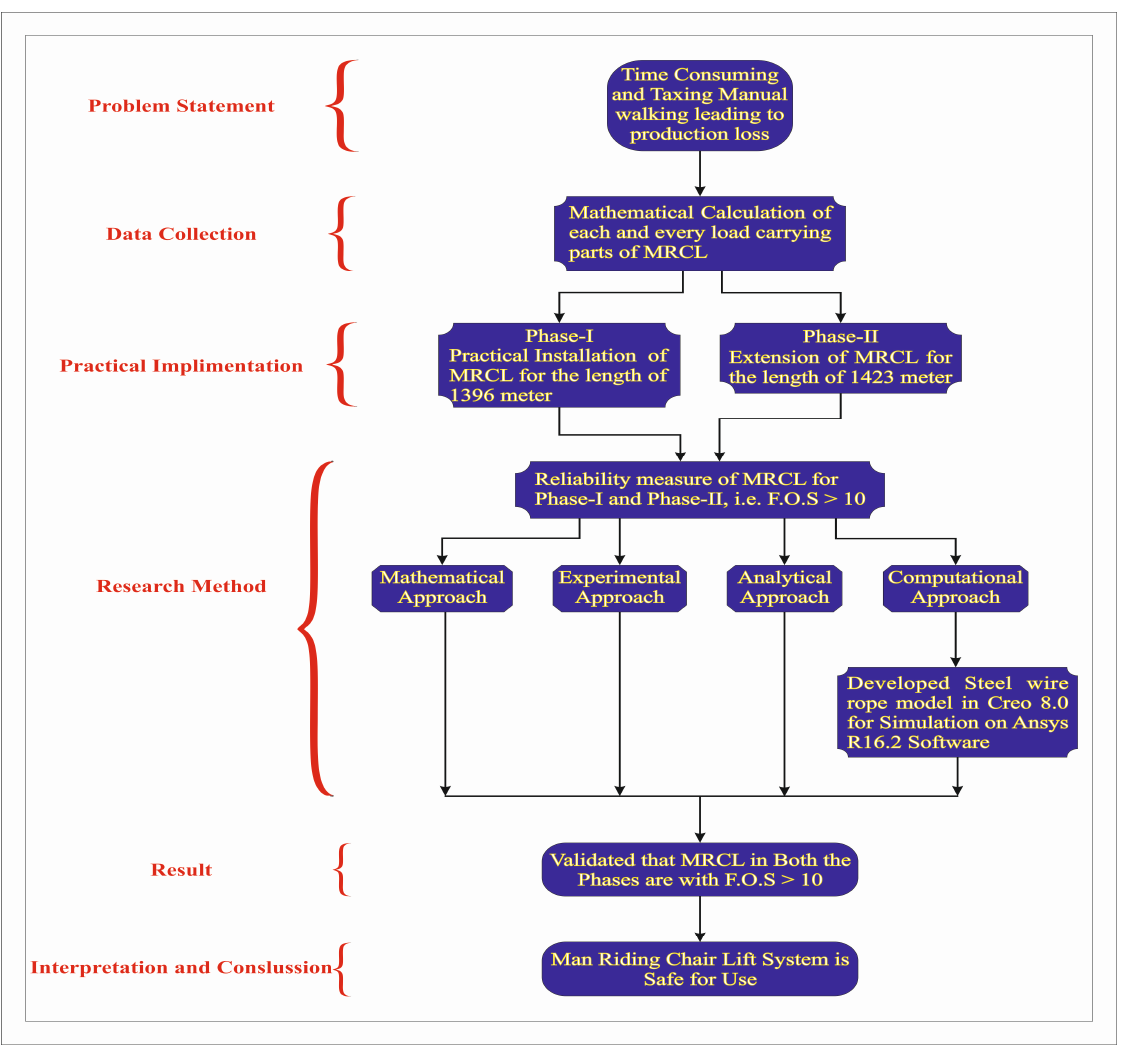
Figure 4. Research Methodology.